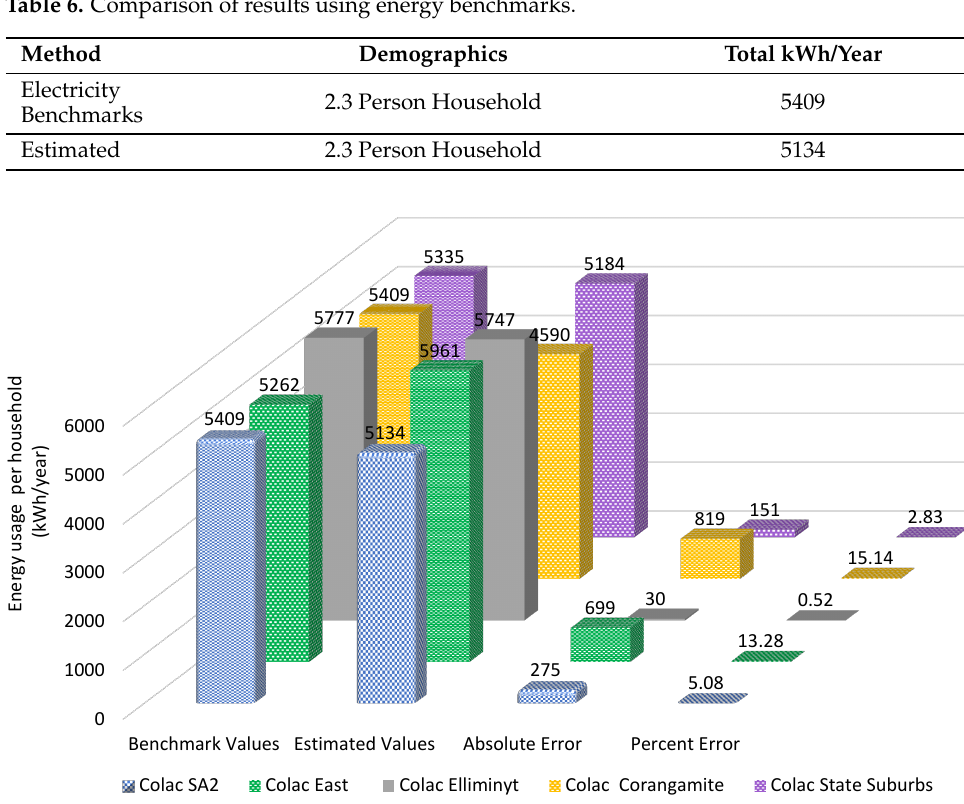
Figure 5. Comparison of benchmark and estimated values for five